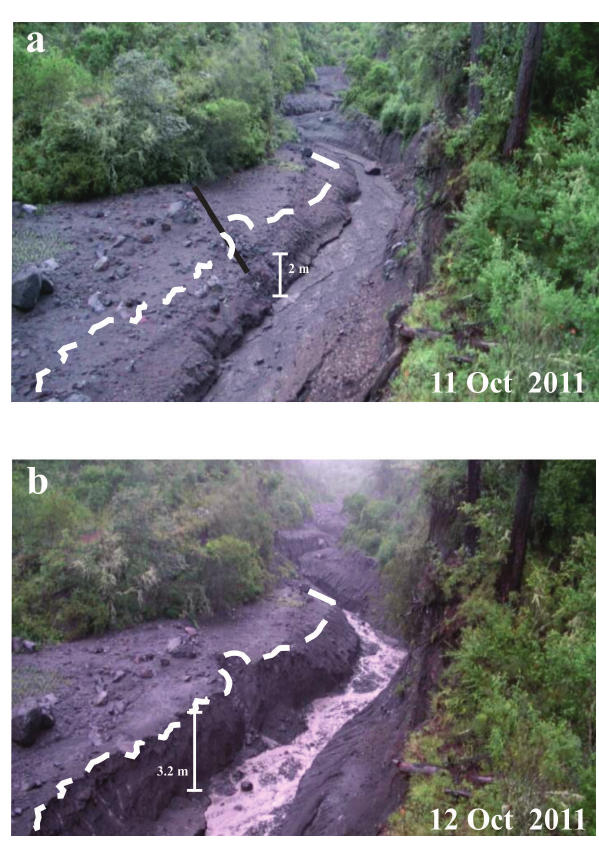
Figure 6. Images showing the morphology of the channel at the monitoring site of the Montegrande ravine (a) the day before and (b) the day after Hurricane Jova.